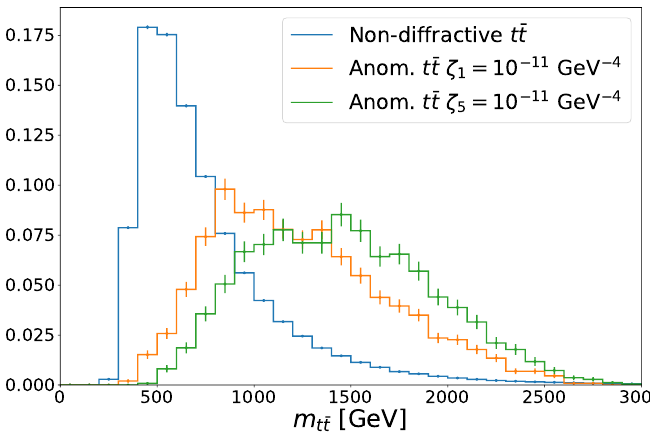
Figure 4. Invariant mass spectrum of the t ¯ t system as reconstructed from its decay products. Only events passing the pre-selection requirements are shown. Histograms are normalized to unity. The blue histogram represents the non-diffractive QCD t ¯ t component. The green and orange distributions represent the prediction of anomalous t ¯ t production assuming the coupling values of ζ ζ 5 = 10 − 11 GeV − 4